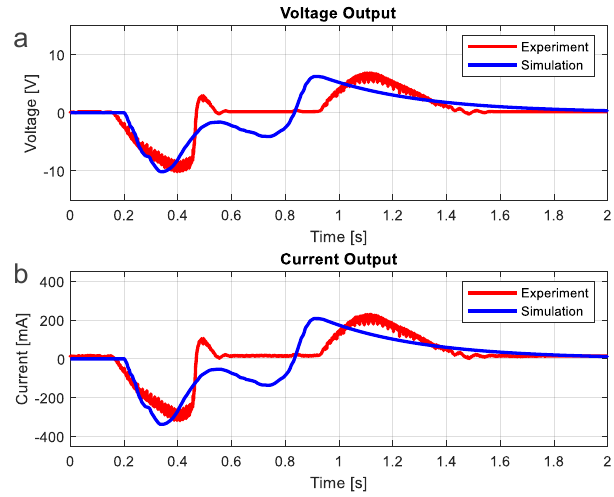
Figure 9. Voltage and Current of Lead-Screw Model from Experiment and Simulation. ( a ) Voltage of Lead-Screw Model. ( b ) Current of Lead-Screw Model.